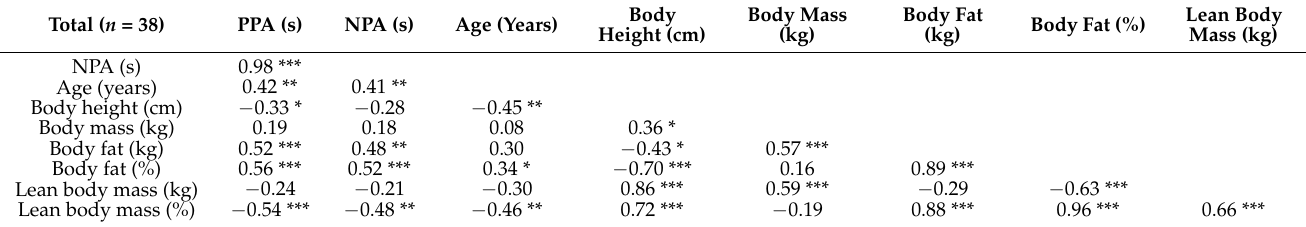
Table 4. Pearson’s correlation coefficients between studied variables for total sample of subjects.